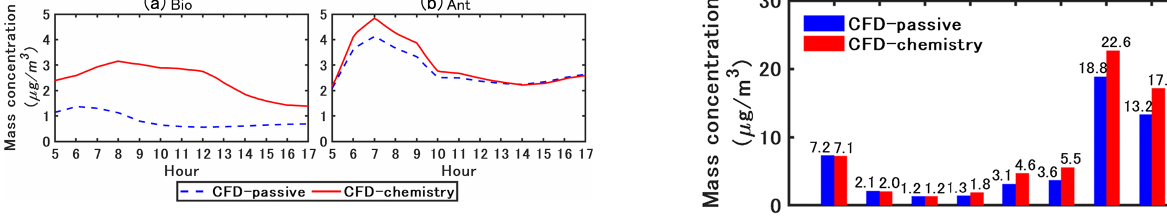
Figure 15. Simulated time-varying concentration of organic matter. Bio refers to organic matter formed from biogenic precursors. Ant refers to organic matter formed from anthropogenic precursors.